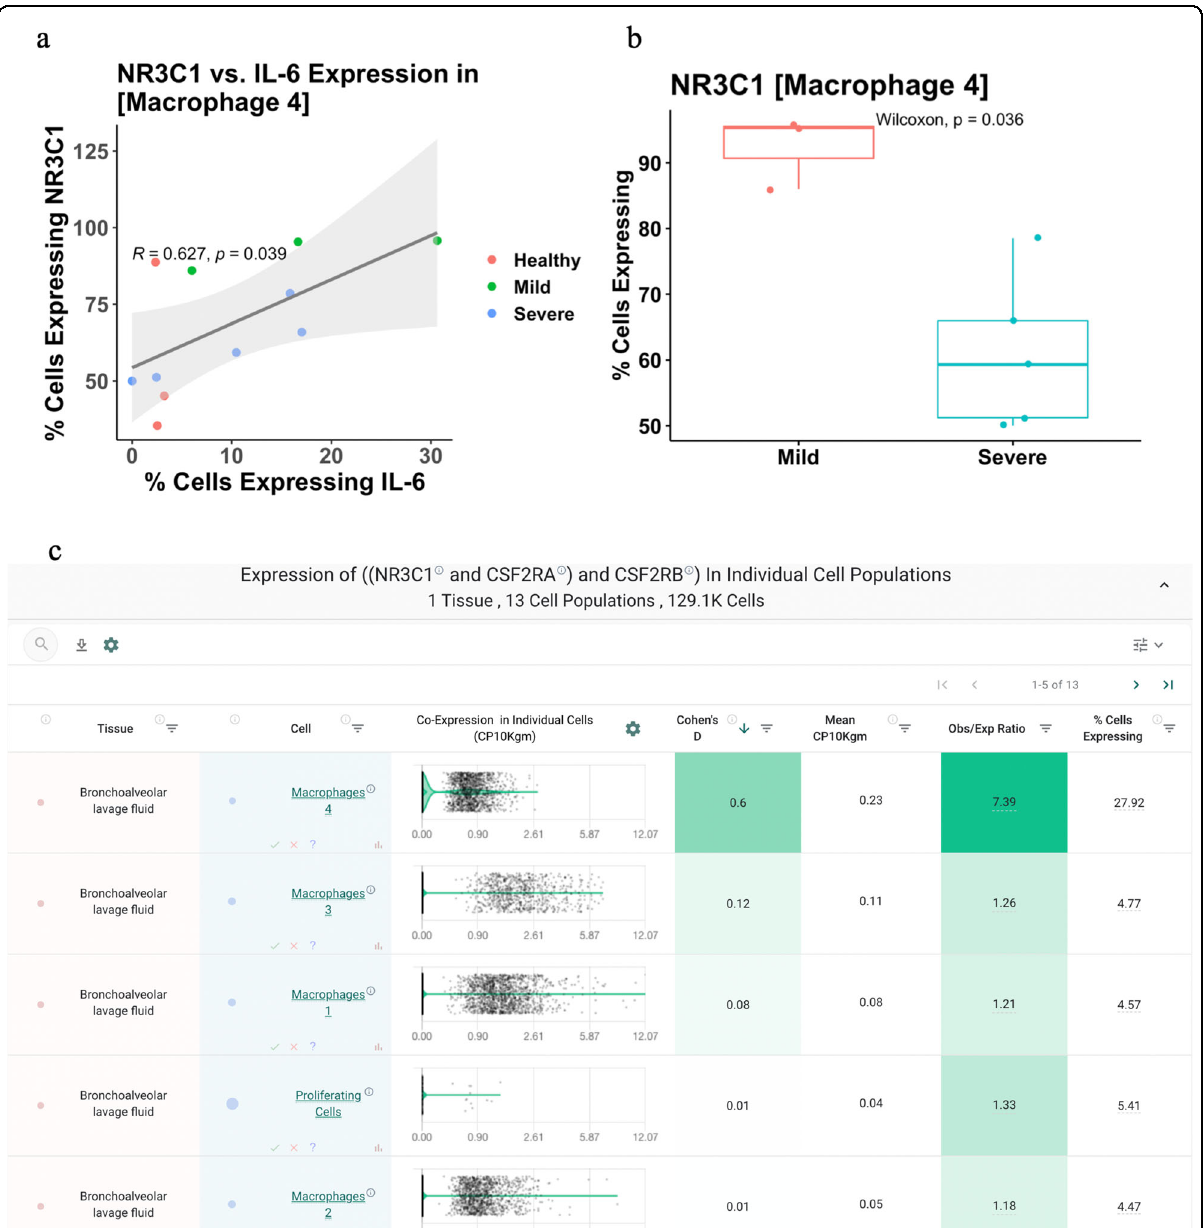
Fig. 7 Relationship of NR3C1 and IL-6 expression to COVID-19 status and clinical severity. A Correlation between IL-6 and NR3C1 expression in the macrophage population found to most robustly co-express these two genes ( “ Macrophages 4 ” ). Each dot represents the percentage of cells from this cluster (i.e., cell population) in which IL-6 and NR3C1 were detected, and dots are colored by COVID-19 status and clinical severity. Values shown are the Pearson correlation coef fi cient ( “ R ” ) and corresponding p -value ( “ p ” ). B Comparison of NR3C1 expression in the “ Macrophage 4 ” cell population from patients with mild versus severe COVID-19. C Coexpression of NR3C1 with the two subunits of the GM-CSF receptor (CSF2RA and CSF2RB) in the bronchoalveolar lavage fl uid of COVID-19 patients ( n = 9; 3 mild, 6 severe). Top coexpressing populations, all of which are macrophages, are